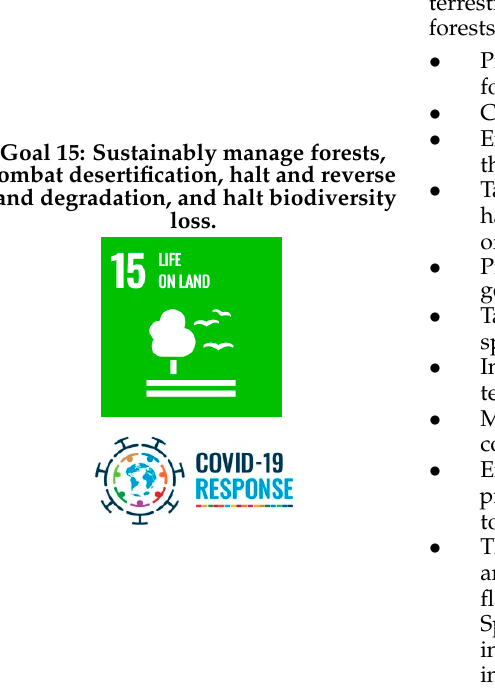
Table 5. Impact of the Sustainable Development Goals on IoT applications for improving health and the environment. SDGs Targets Goals and Application to IoT Systems